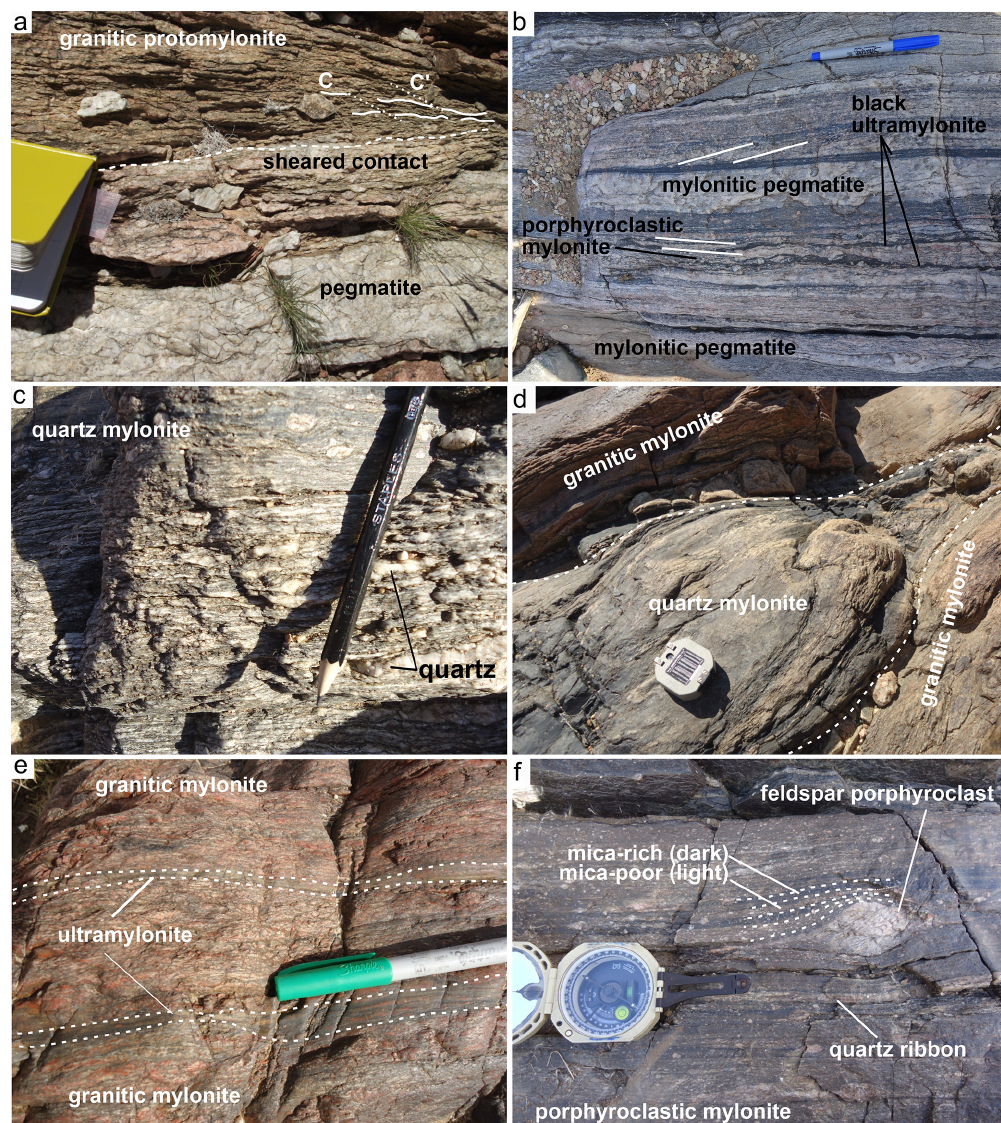
Figure 3. Field photographs of lithologies found in the Coboop Island shear zone core with selected layer interfaces indicated with dotted lines. All photos oriented with NW to the right and SE to the left. (a) Granitic protomylonite with sheared intrusive pegmatite contact. Field notebook edge is 12cm. (b) Layers of mylonitic pegmatite, porphyroclastic mylonite, and black ultramylonite crosscutting foliation at low angle (white lines). Pen is 10mm wide. (c) Quartz-rich mylonite with strongly aligned and tailed quartz aggregates, interlayered with aluminosilicate-rich matrix. Pencil is 8mm wide. (d) Boudinaged quartz-rich mylonite contained between layers of granitic mylonite. Compass is 70mm wide. (e) Granitic mylonite cut by granitic ultramylonite horizons. Pen is 10mm wide. (f) Porphyroclastic mylonite with feldspar porphyroclast derived from pegmatite protolith, wrapped by foliation layers of variable mica content. Compass is 70mm